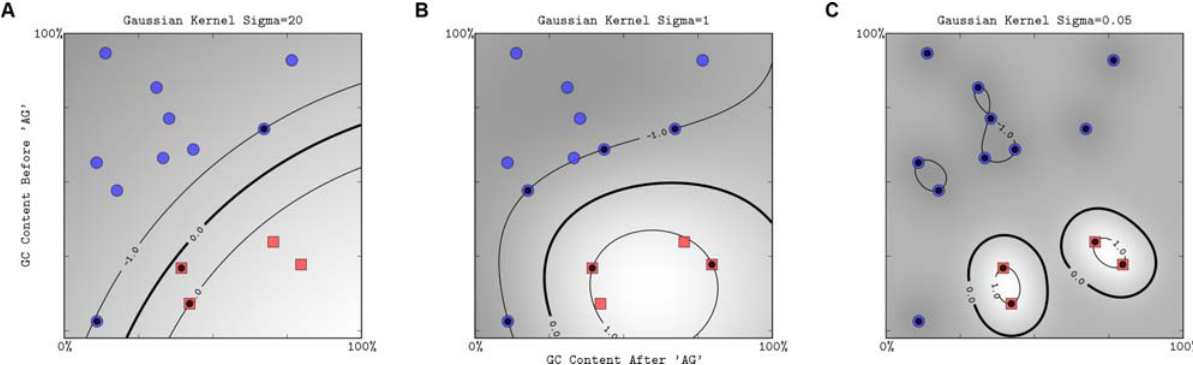
Figure 7. The effect of the width parameter of the Gaussian kernel ( s ) for a fixed value of the soft-margin constant. For large values of s (A), the decision boundary is nearly linear. As s decreases, the flexibility of the decision boundary increases (B). Small values of s lead to overfitting (C). The figure style follows that of Figure 3.